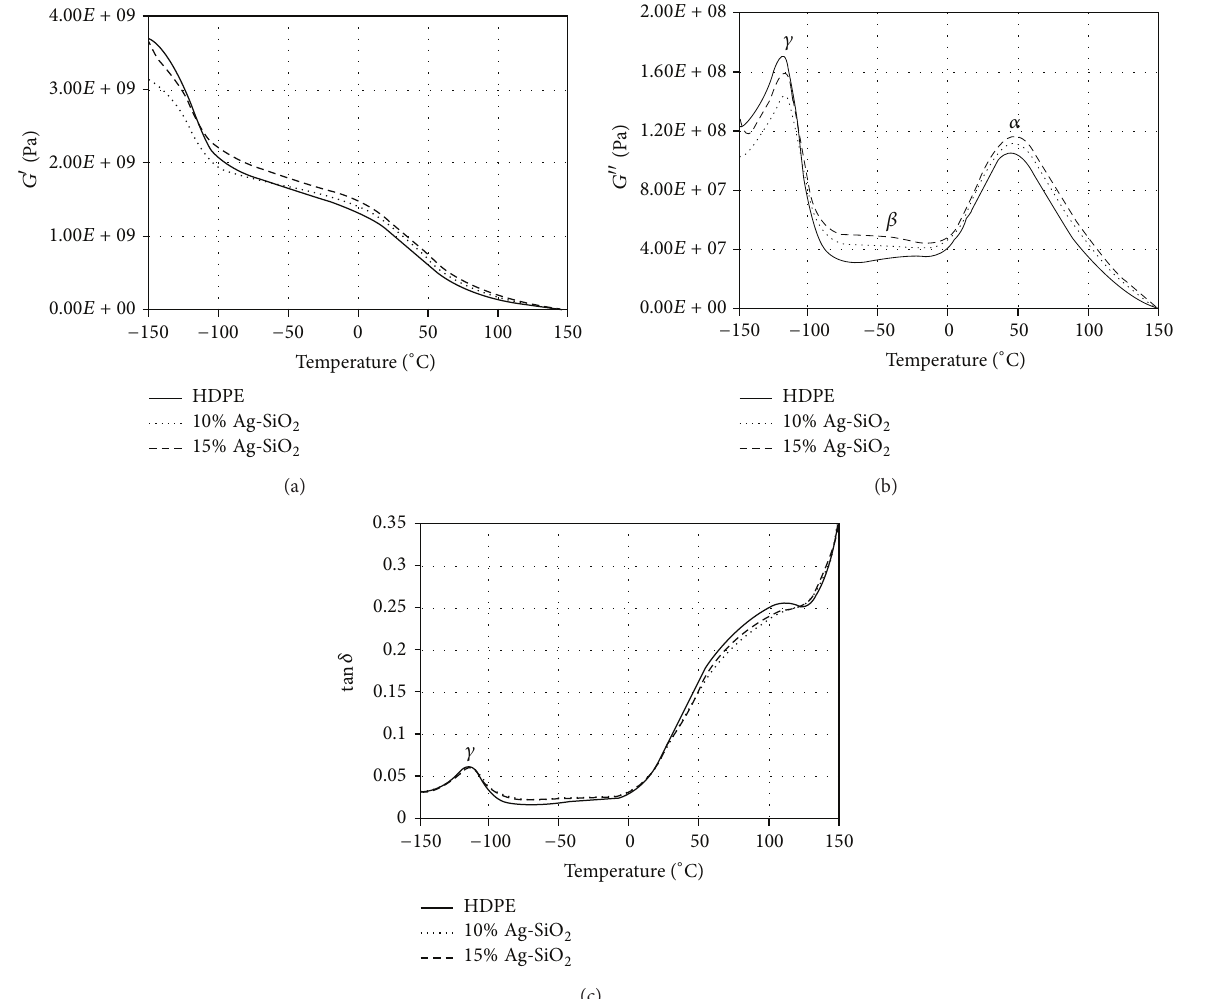
Figure 9: Dynamic mechanical relaxation behavior versus temperature of HDPE and silica containing immobilized nanosilver filled HDPE composites at frequency of 1Hz: 𝐺 󸀠 (a), 𝐺 󸀠󸀠 (b), and tan 𝛿 (c). Table 5: DMTA results for HDPE and the HDPE composites containing Ag-SiO